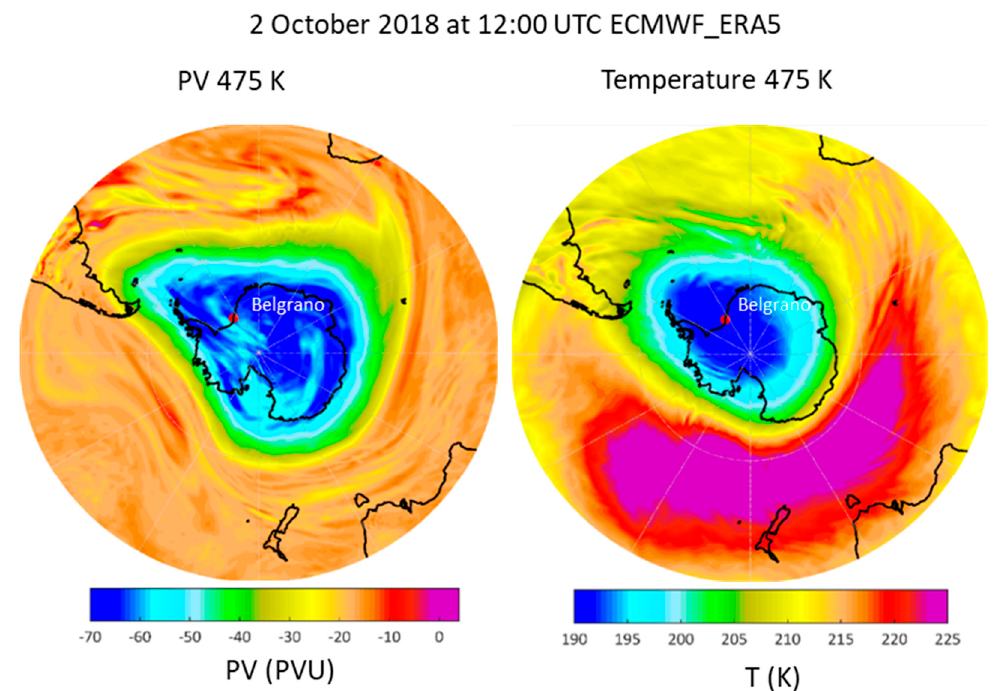
Figure 1. Spatial distribution of PV (Pressure · Volume) and temperature in the Antarctic and surroundings at the 475 K isentropic level on 2 October 2018 at 12:00 UTC. The location of Belgrano II is indicated with a red dot over Antarctica. Edges of the vortex are usually considered at the highest PV gradients, which in this figure correspond to PV values around –40.